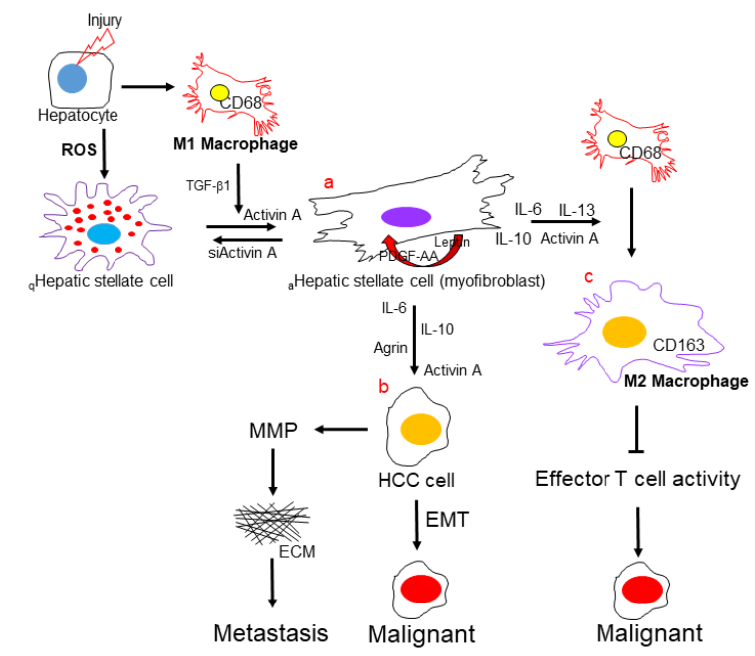
Figure 5. Activated HSCs modulate the immune microenvironment during HCC development. Graphical summary demonstrates the major components, including ( a ) HSCs, ( b ) hepatocytes, ( c ) macrophages, and molecules that are involved in the immune microenvironment in promoting HCC.